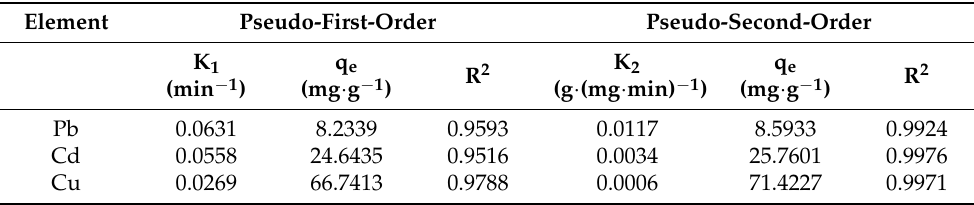
Cd, and Cu after GBC